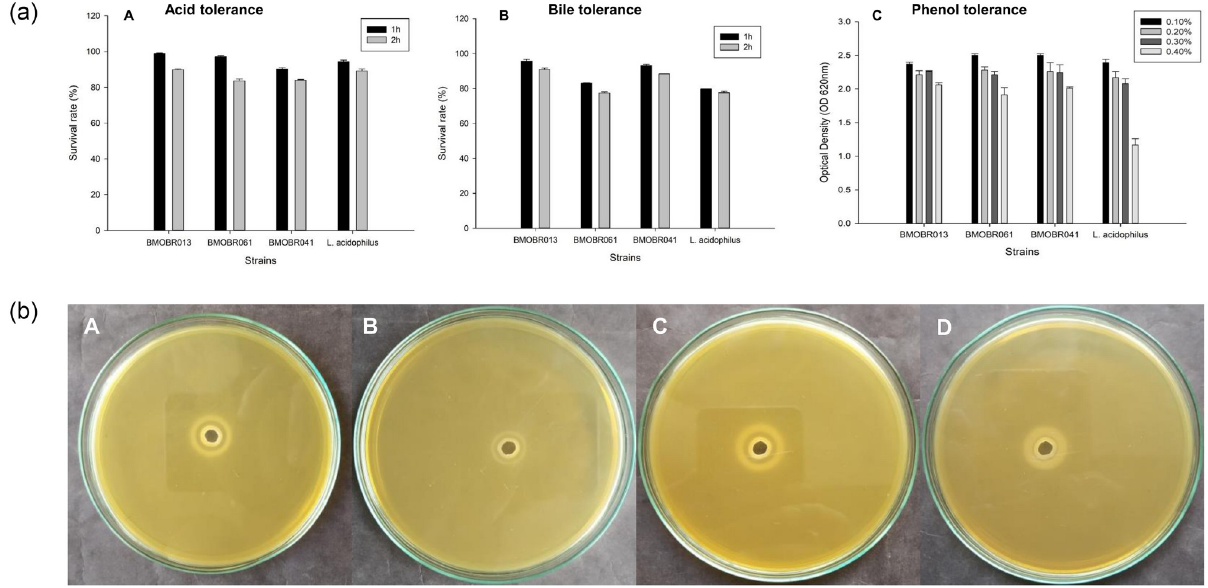
Fig 2. a . In vitro cell viability of bacterial isolates BMOBR013, BMOBR061 and BMOBR041 (A) acid tolerance, (B) bile tolerance (0.3%), and (C) phenol tolerance. All the three experiments carried out in triplicates and error bars indicate standard deviation of the mean values obtained from statistical analysis by Tukey’s post-hoc analysis ( p < 0.05). b . Bile salt hydrolase activity of LAB strains (A) L . pentosus BMOBR013, (B) L . pentosus BMOBR061, (C) P . acidilactici BMOBR041, (D) L . acidophilus NCIM 2285 on MRS-sodium taurodeoxycholic